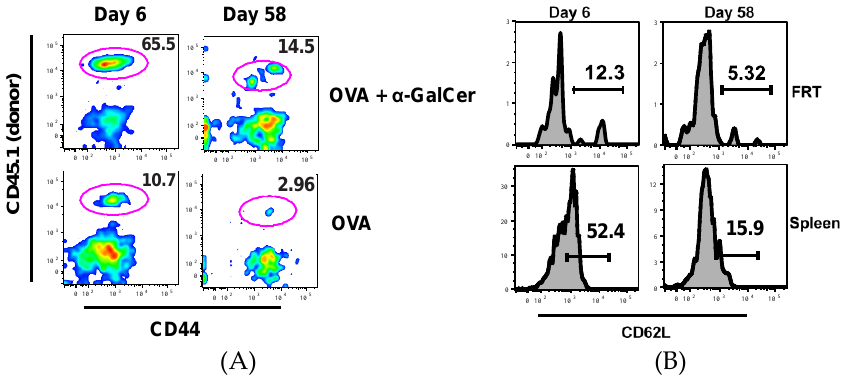
Figure 2. IN vaccination induces persistent OVA specific CD8 + T cells in FRT. Plots show frequency of OT-I T cells among CD8 + T cells present in FRT of mice immunized with OVA or OVA + α GalCer at six and 58 days after IN vaccination ( A ). Plot shows CD62L expression on OT-I cells isolated from the FRT and spleen of mice at different times after immunization with OVA + α GalCer ( B